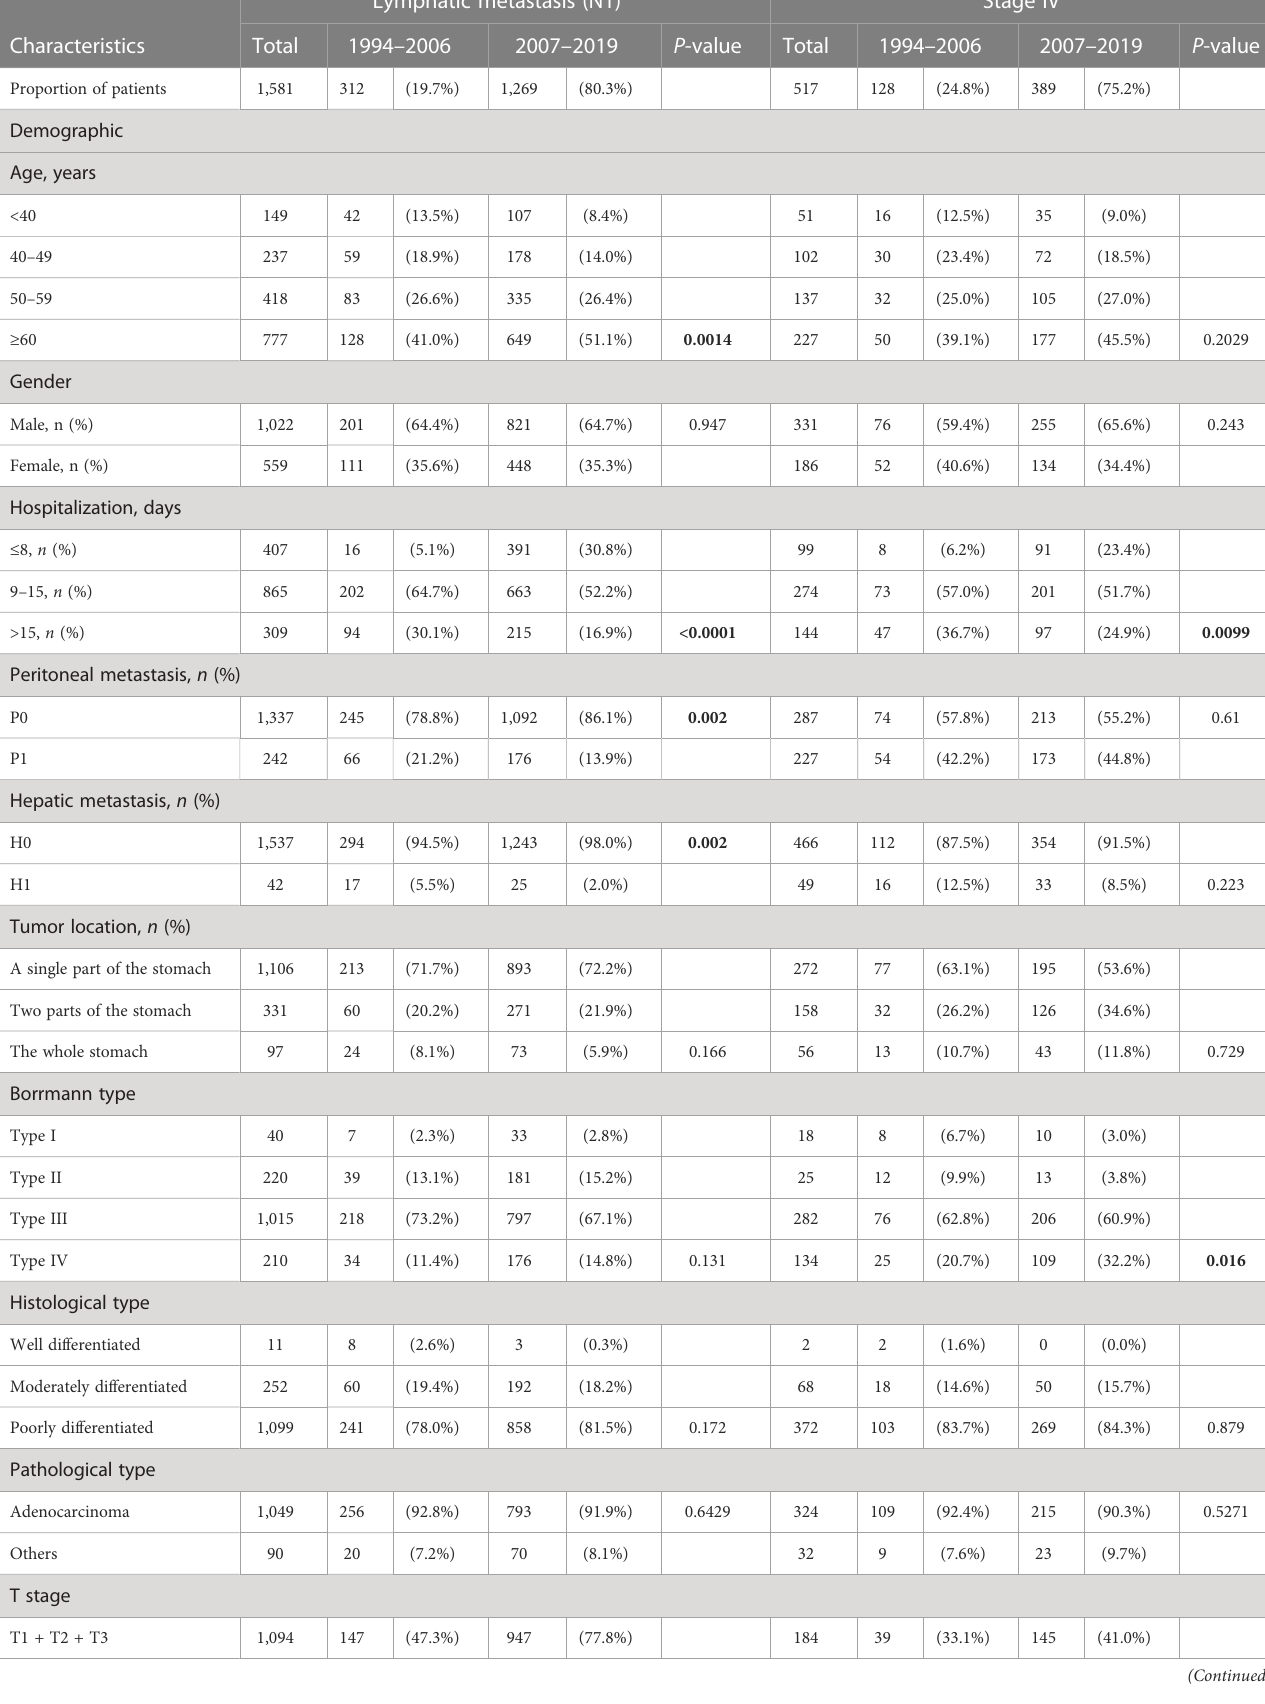
TABLE 2 Demographics and characteristics of patients in the N1 group and the stage IV